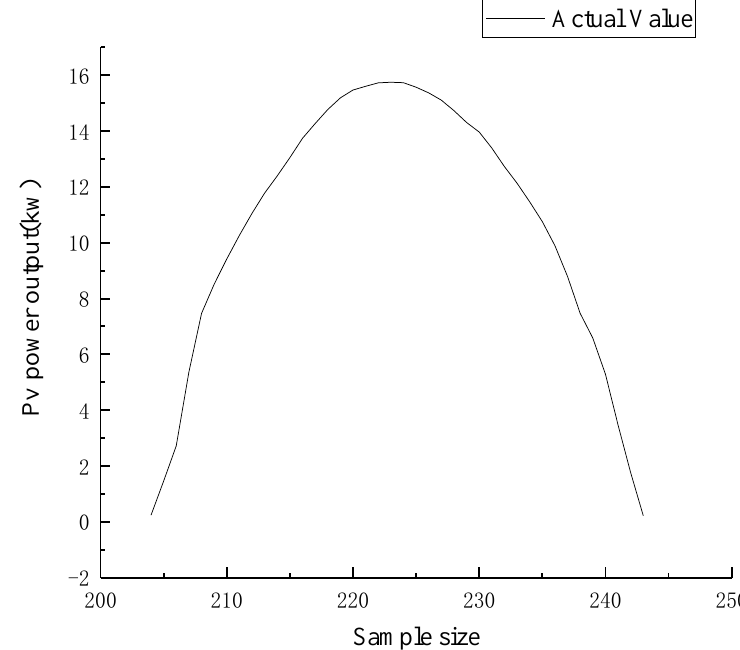
Figure 1. Period of stable photovoltaic output.